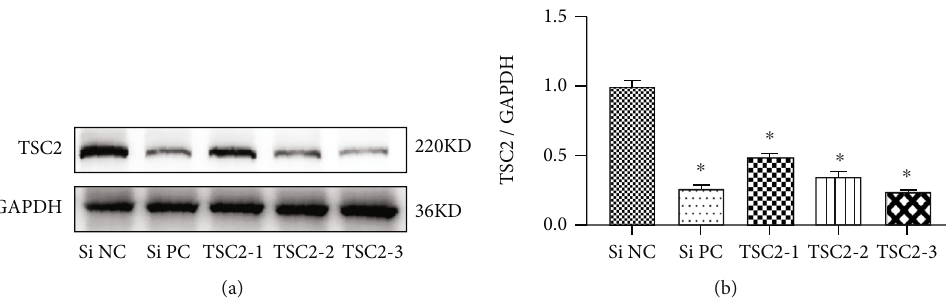
Figure 6: Detection of siRNA TSC2 knockdown e ffi ciency in podocytes. (a – b) Representative Western blot bands and quanti fi cation of TSC2 protein expression. Podocytes were transfected with TSC2 siRNA, positive siRNA (Si PC), or negative control siRNA (Si NC). Data were shown as the mean ± SD , n = 3 ; ∗ P < 0 : 05 versus the Si NC